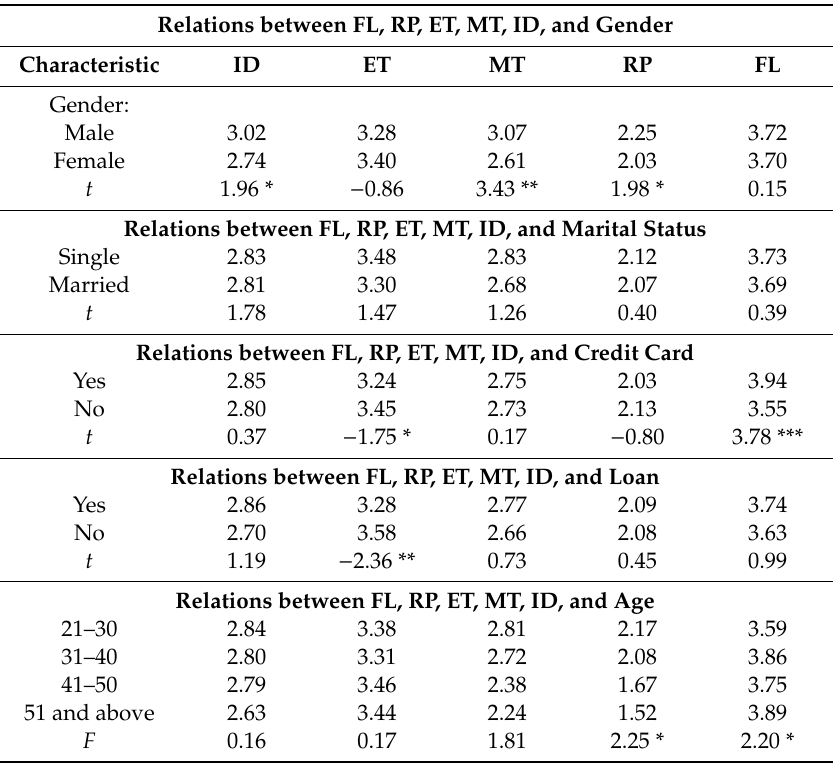
Table 5. Relations between demographic profile and